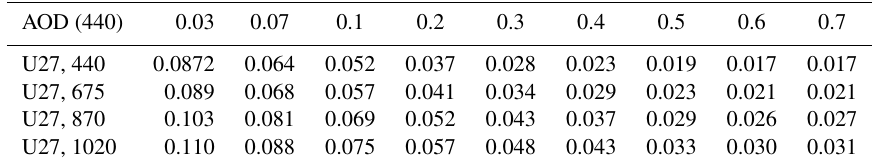
Figure 21. Uncertainties for SSA retrievals at the Mezaira site: (a) 440, (b) 675, (c) 870, and (d) 1020nm. Table 14. Average SSA uncertainties estimated at